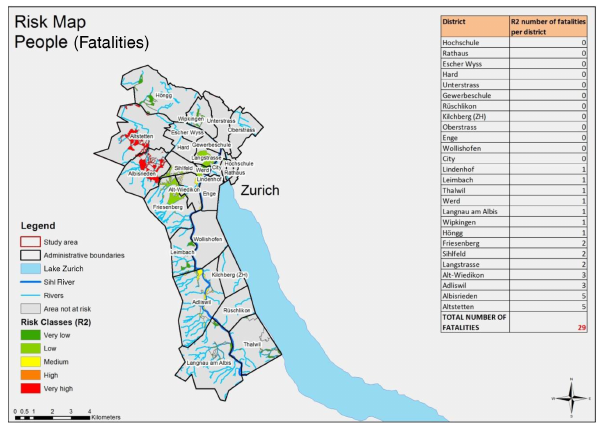
Figure 5. Relative risk map for fatalities with statistics at the district